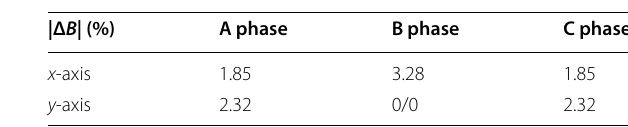
Table 1 Errors at different conductor sags